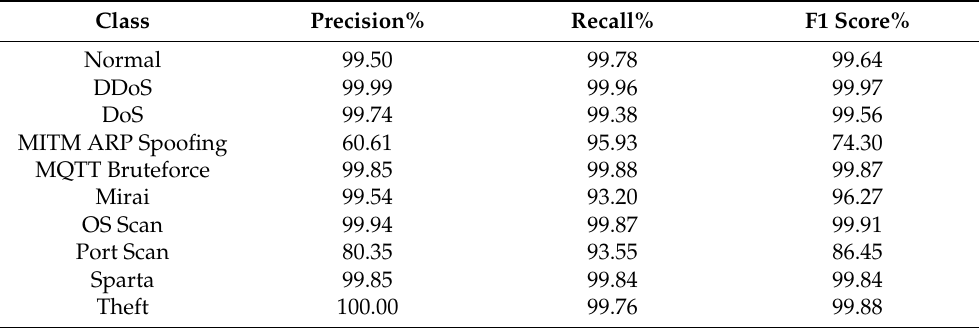
Table 10. IoT-DS-1 multiclass classification (BoT-IoT, IoT network intrusion, and MQTT-IoT- IDS2020